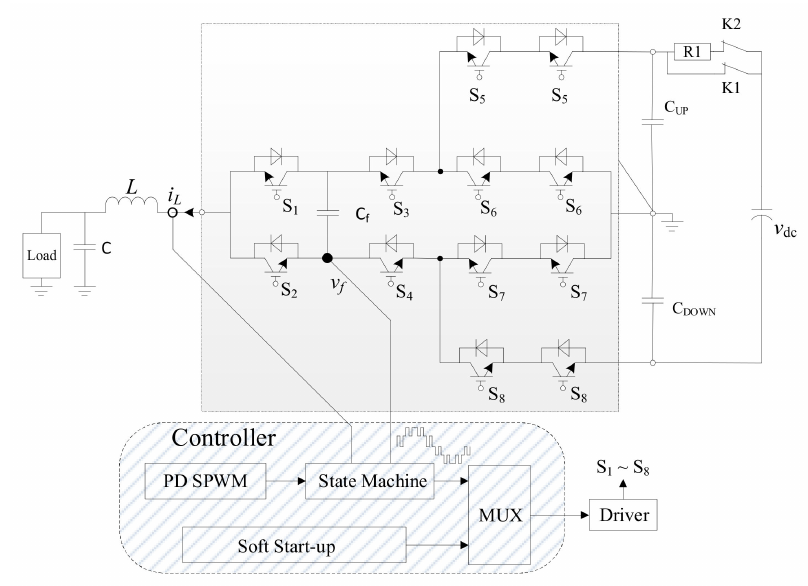
Figure 16. Proposed control scheme for soft start-up and modulation scheme.